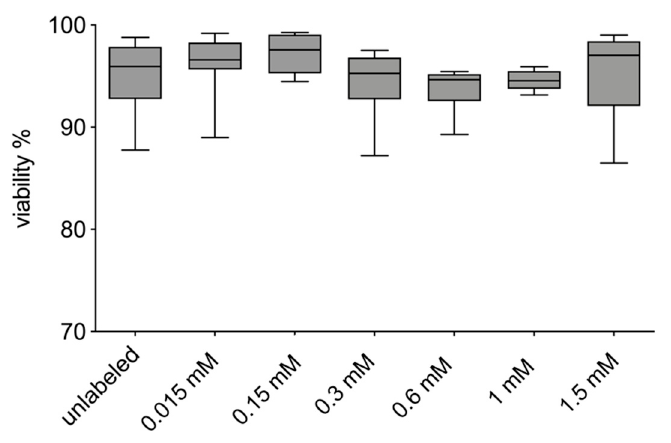
Figure 5. Trypan Blue exclusion test: There was no difference in the viability of the VSOPs-labeled hASCs compared to the unlabeled control.